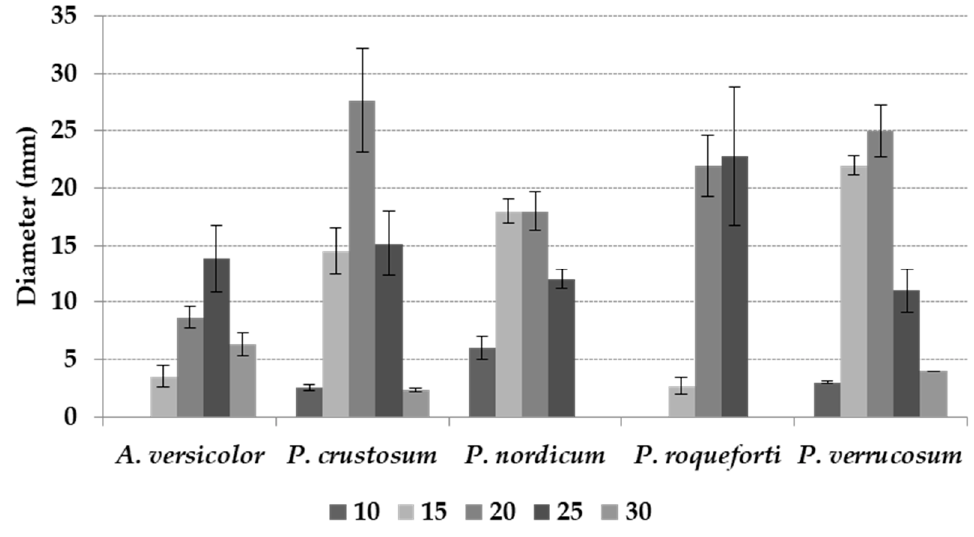
Figure 2. Mean colony diameter (mm) after 21 days of incubation of Aspergillus versicolor ,